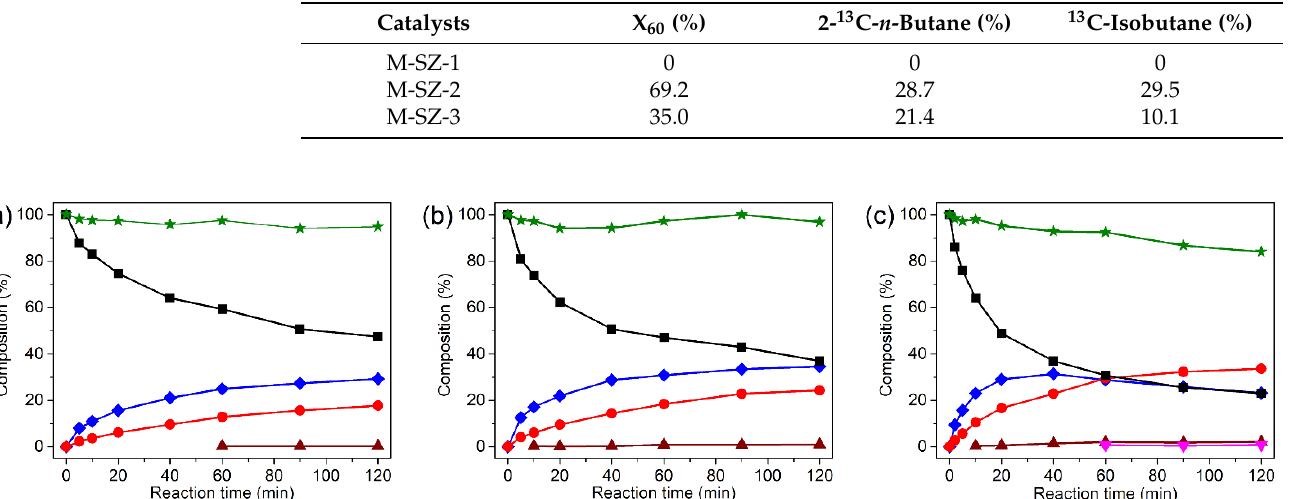
Figure 7. Butane isomerization catalyzed by M-SZ-2 at ( a ) 393 K, ( b ) 413 K, and ( c ) 433 K. ( ■ ) 1- 13 C- n -butane, ( ◆ ) 2- 13 C- n -butane, ( ● ) 1- 13 C-isobutane and 2- 13 C-isobutane, ( ▲ ) 13 C-isopentane, ( ▼ ) 13 C- propane, and ( ★ ) the total amount of 13 C-labeled species.